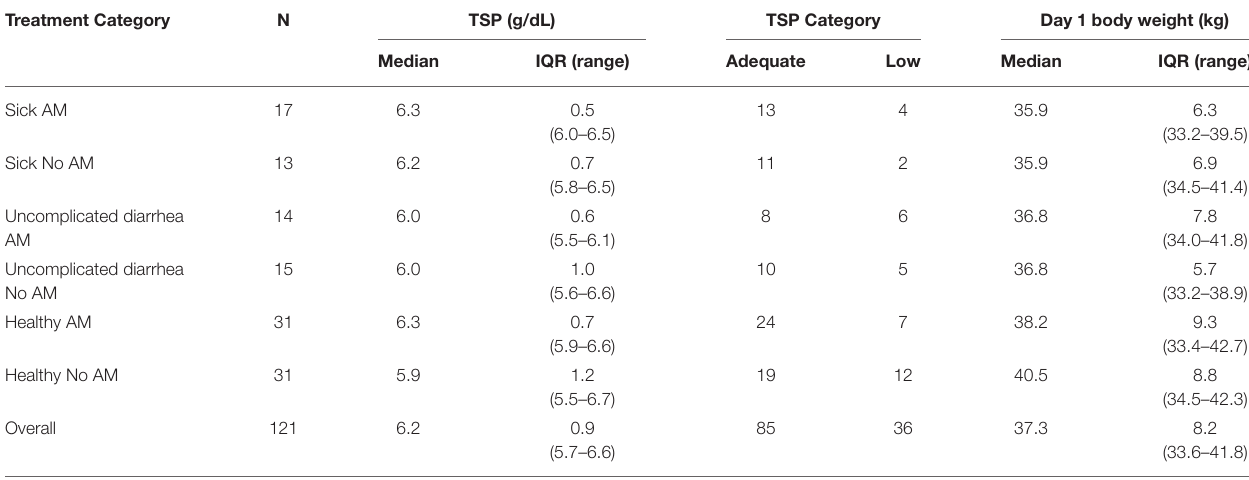
TABLE 3 | Distribution of calves’ total serum protein concentration (TSP), bodyweight the day after birth, and assigned TSP category (adequate > 5.7 g/dL, low ≤ 5.7 g/dL) by post-hoc study group at enrollment. Treatment